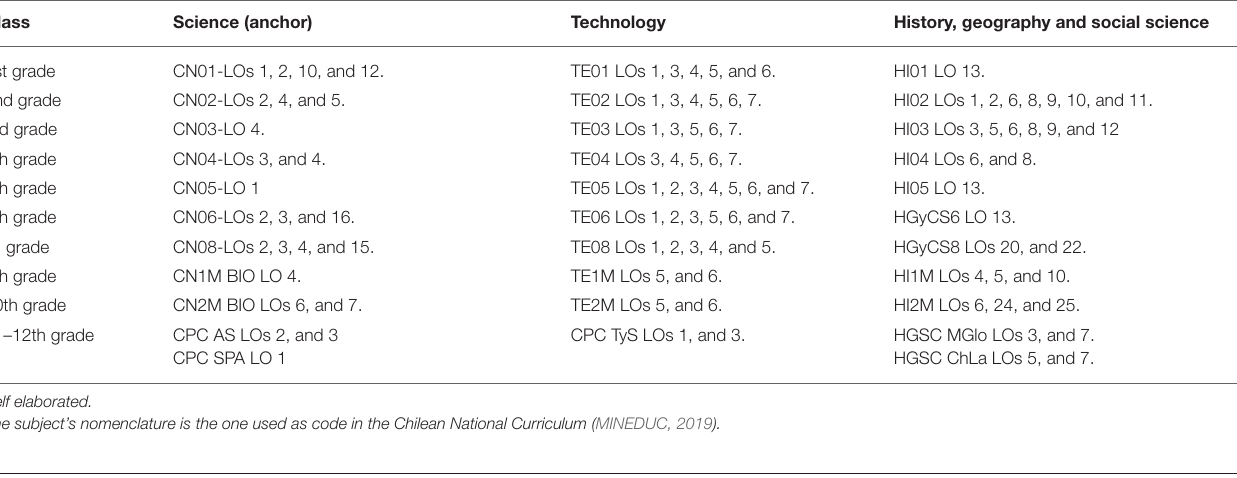
TABLE 2 | Summary of the mapped LOs with connections opportunities.